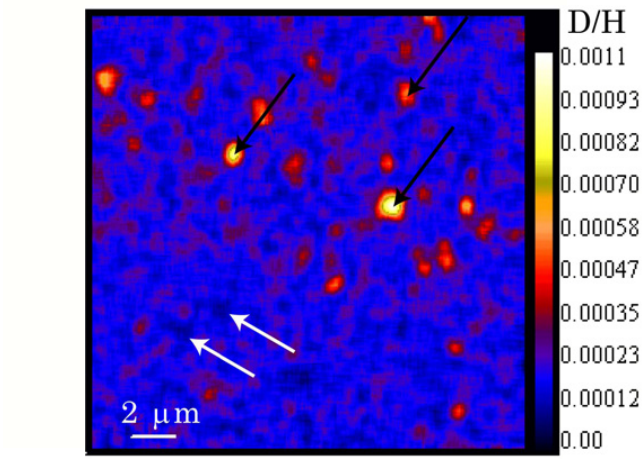
Figure 8. NanoSIMS image of the IOM of Orgueil. The image covers an area of 20 × 20 (cid:2) m 2 . At this scale, D appears heterogeneously distributed, with the occurrence of D-rich hot spots (black arrows) but also small areas depleted in D (white arrows). These hot spots cover ca 25% of the surface